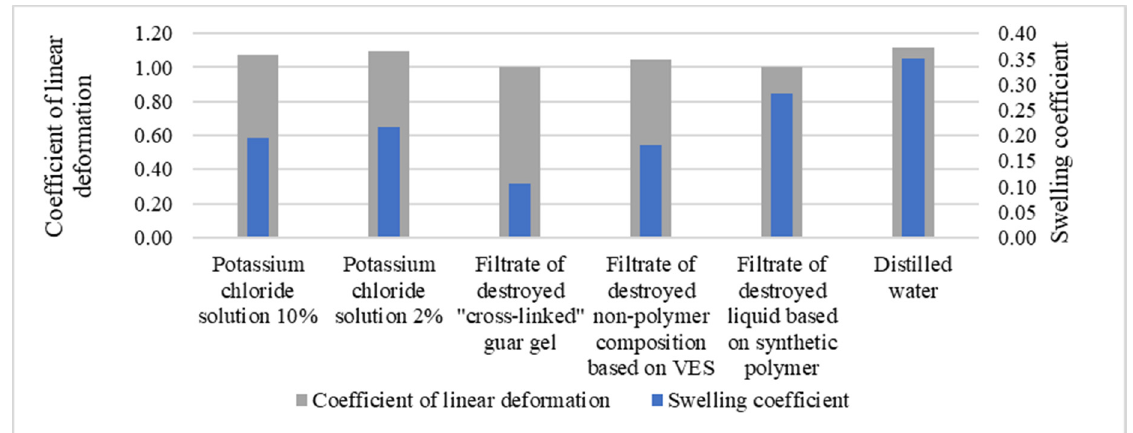
Figure 12. Results of calculating the swelling and linear deformation coefficients.